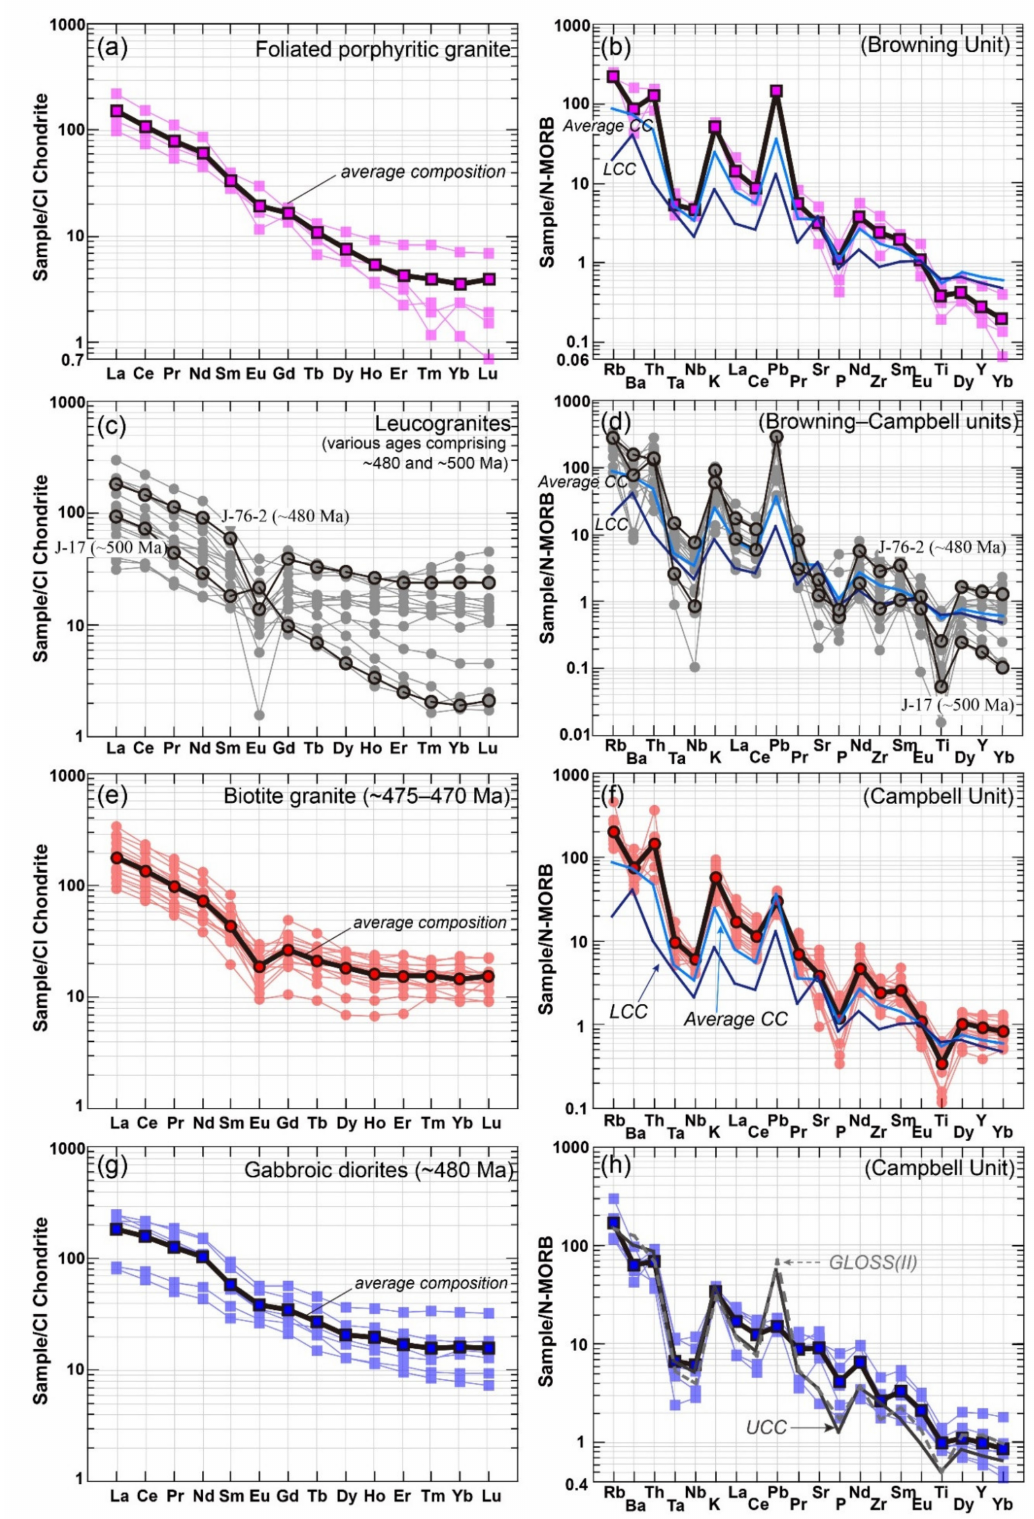
Figure 8. ( a , c , e , g ) Chondrite-normalized REE and ( b , d , f , h ) N-MORB-normalized multi-element diagrams for the BIU–CIU rocks: ( a , b ) Foliated porphyritic granite (BIU), ( c , d ) leucogranites (BIU–CIU), ( e , f ) biotite granite (CIU), and ( g , h ) gabbroic diorites (CIU). Normalization values were taken from Sun and McDonough [44], while the compositions of the average subduction zone seafloor sediment (global subducting sediment, GLOSS-II) and continental crust are taken from Plank [45] and Rudnick and Gao [46], respectively. CC: continental crust; LCC: lower continental crust; UCC: upper continental